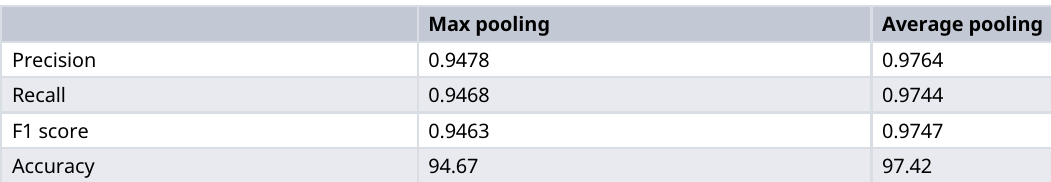
Table 4. Performance of MSTCN using different pooling